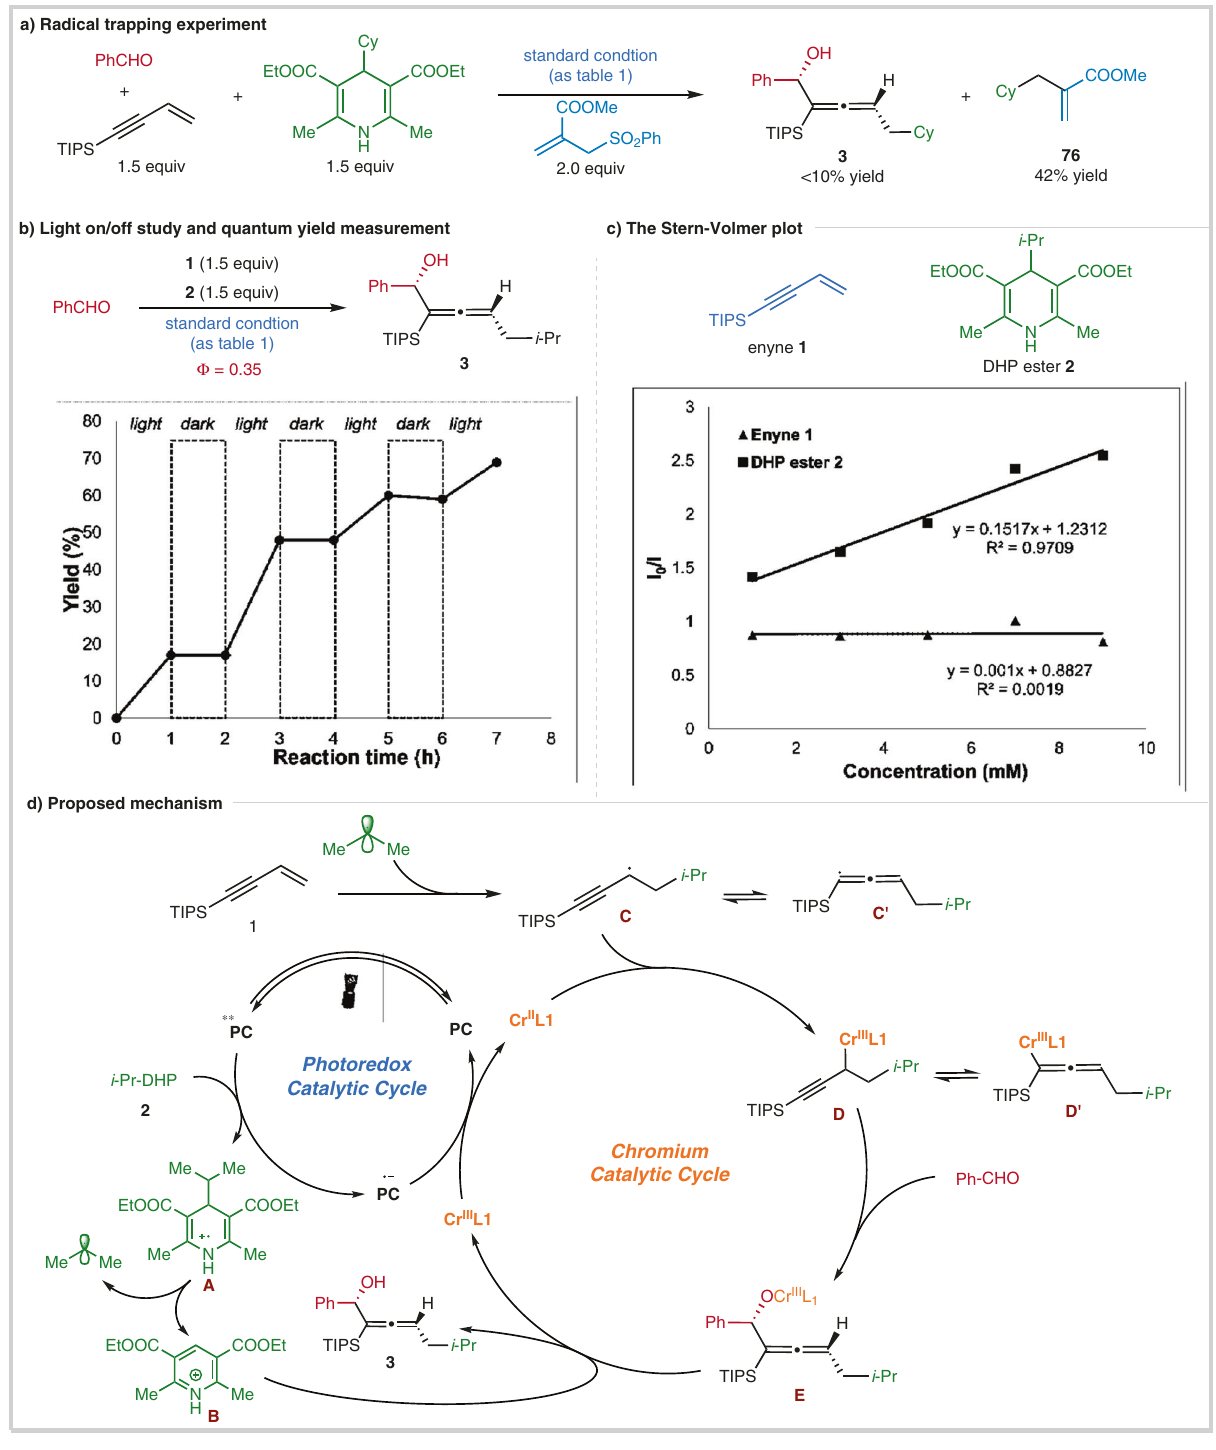
Fig.6|Mechanisticinvestigations.a Radicaltrappingexperiment. b Lighton/offandquantumyieldmearsurement. c TheStern – Volmerplot. d Proposedmechanismfor the 1,4-functionalizaton of